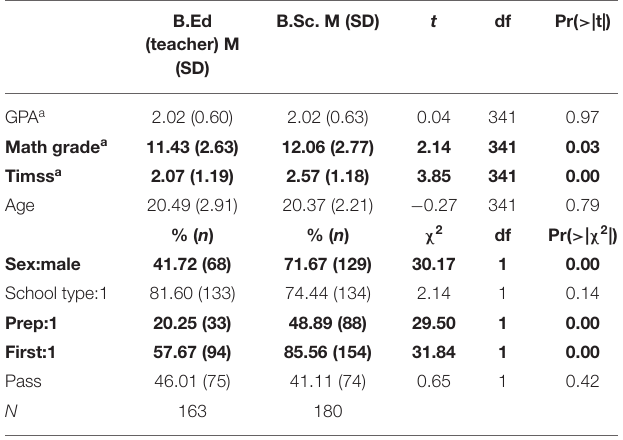
TABLE 3 | Logistic regression with dataC and selected features (dataC select).